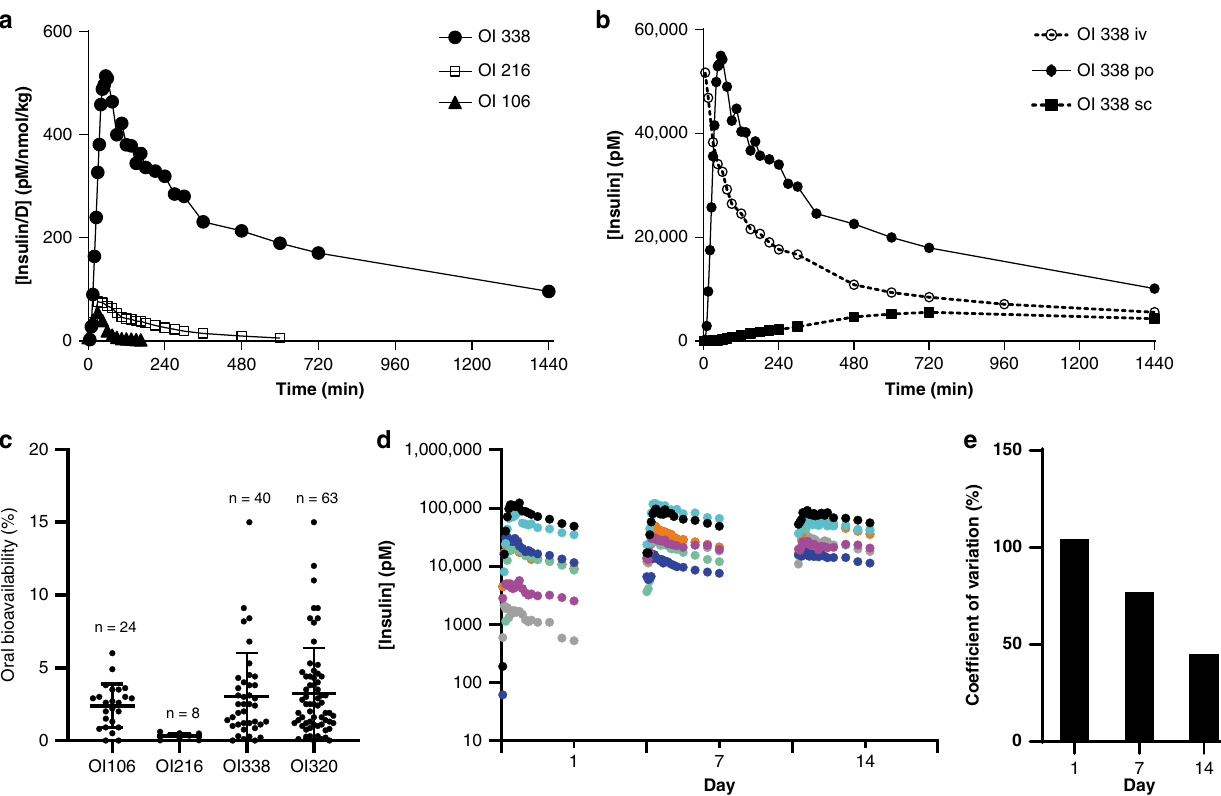
Fig. 3 Pharmacokinetic properties of oral insulin analogues. a Pharmacokinetic pro fi les of OI106 (triangles), OI216 (squares) and OI338 (circles) after single oral dosing in healthy and conscious dogs ( n = 8); the plotted concentrations are exposure divided by the oral dose in nmol/kg for each insulin analogue. Coef fi cient of variation, CV, for the AUC, was 75 – 100%. b Pharmacokinetic pro fi les of in OI338 after IV (2 nmol/kg, n = 8); peroral (105 nmol/ kg, n = 8) and SC (4 nmol/kg, n = 4) administrations in dogs. CV for AUC was around 10% after IV and SC administration and ~100% after oral